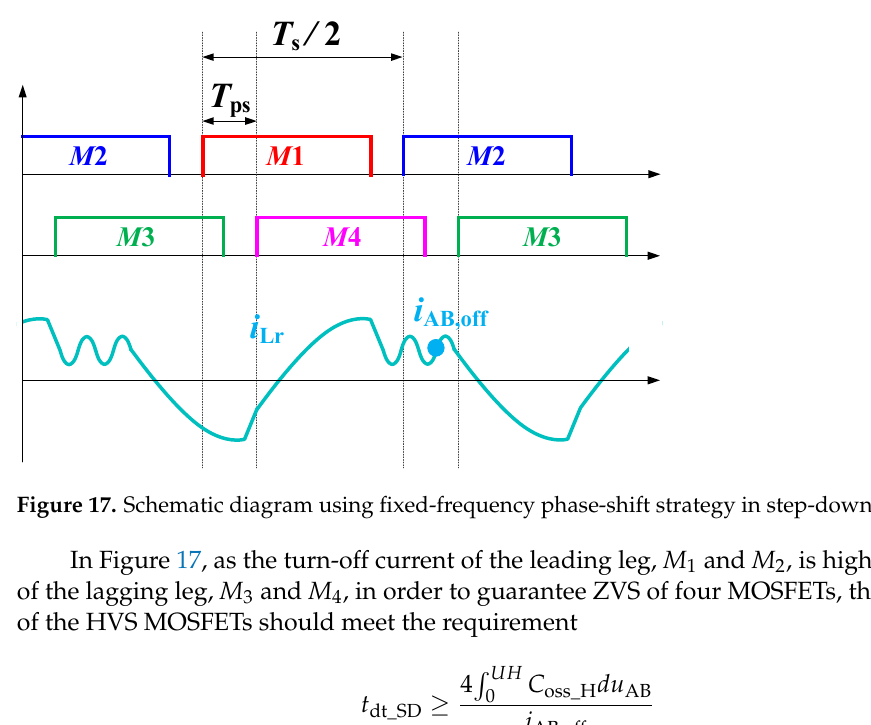
i AB,off can be obtained when the voltage of C r1 and C r2 is 0. Figure 17. Schematic diagram using fixed-frequency phase-shift strategy in step-down mode.